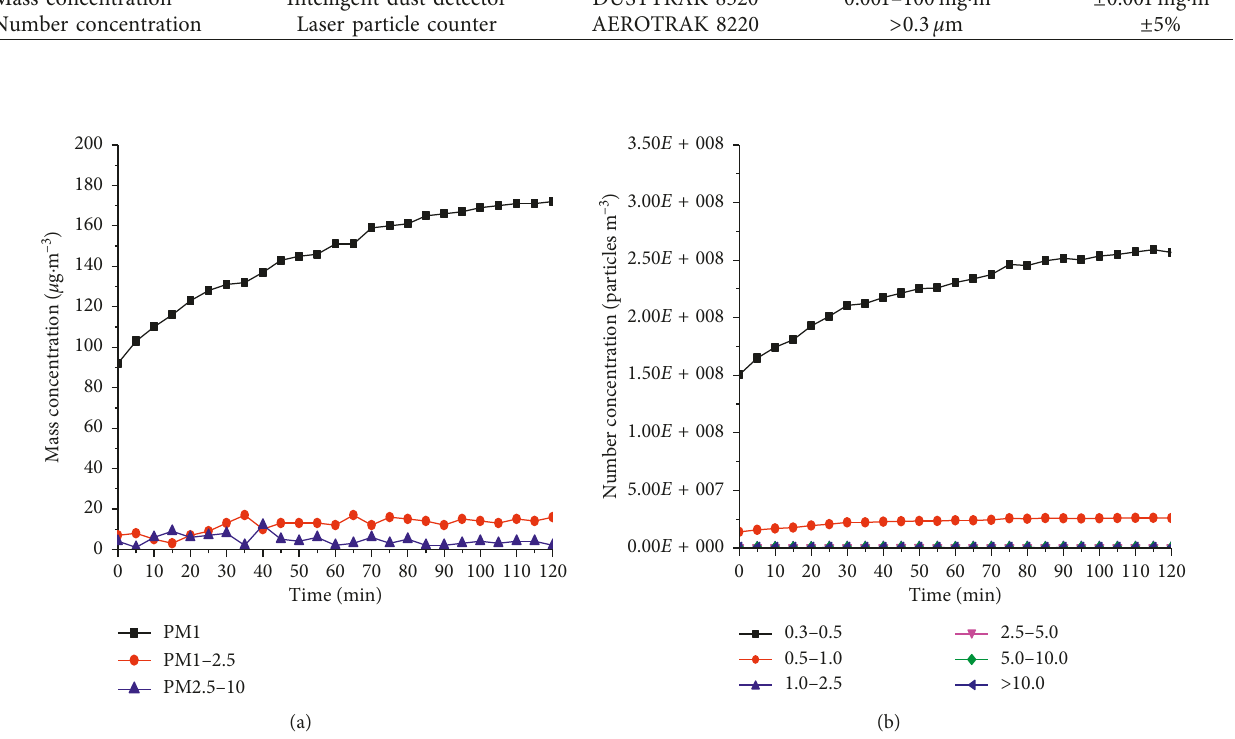
3 : (a) mass concentration; (b) number concentration. 200–300 μ g m (cid:29) · −